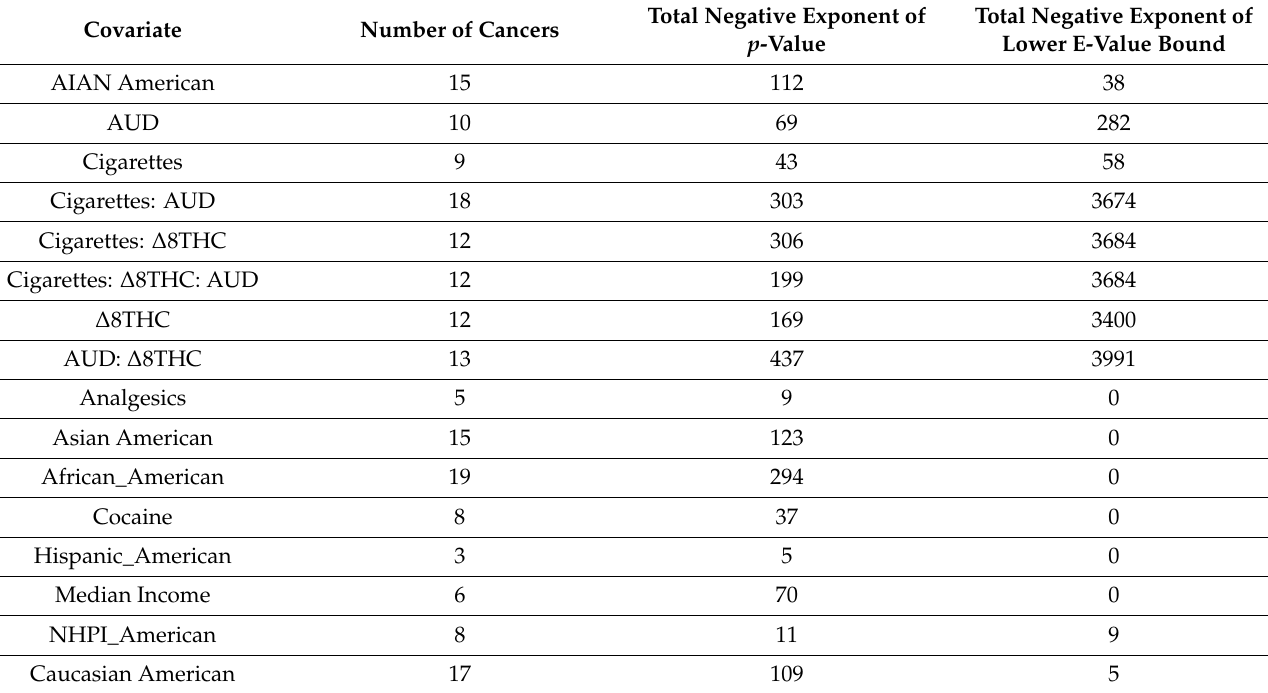
Table 5. A summary of all terms from ∆ 8THC from the interactive panel model at four years